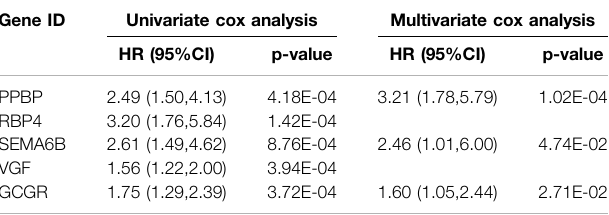
TABLE 1 | Cox regression analysis for screening of IRDEGs in fl uencing the THCA patients ’ prognosis. Gene ID Univariate cox analysis Multivariate cox analysis